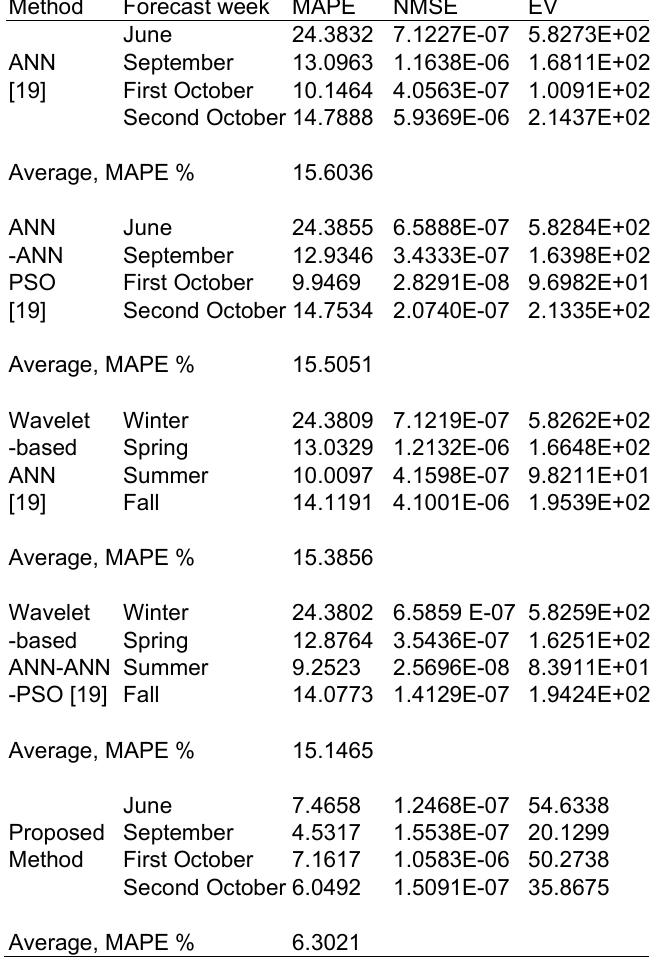
Table 3. Comparative results between the various methods